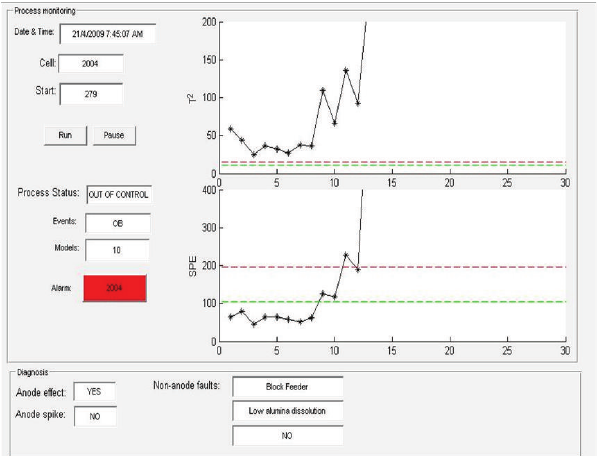
Figure 4: Operator screen shows an indication of an anode effect and its possible causes: a block feeder and low alumina